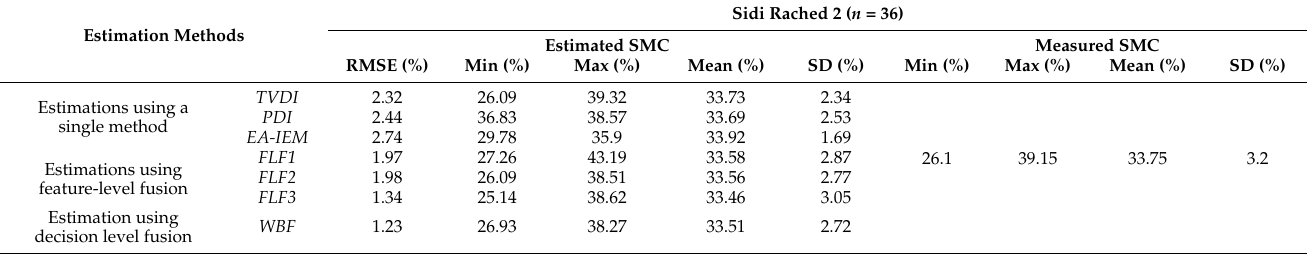
Table 9. The results of each of the used estimation methods in the Sidi Rached 2